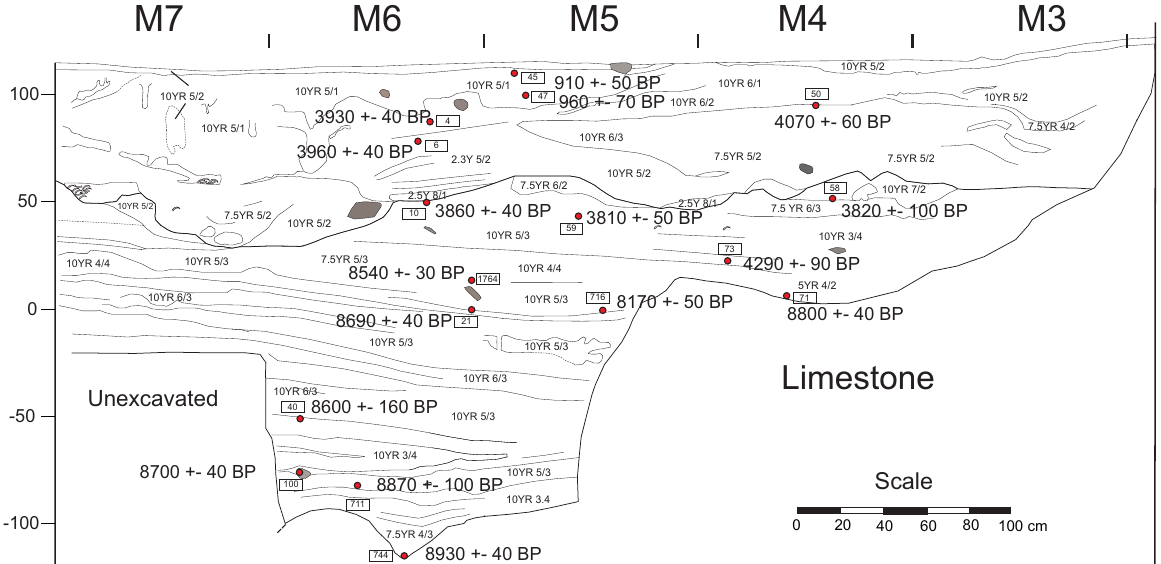
Figure 4 - East profile of the “M Units” showing major stratigraphic layers, soil colors, and radiocarbon